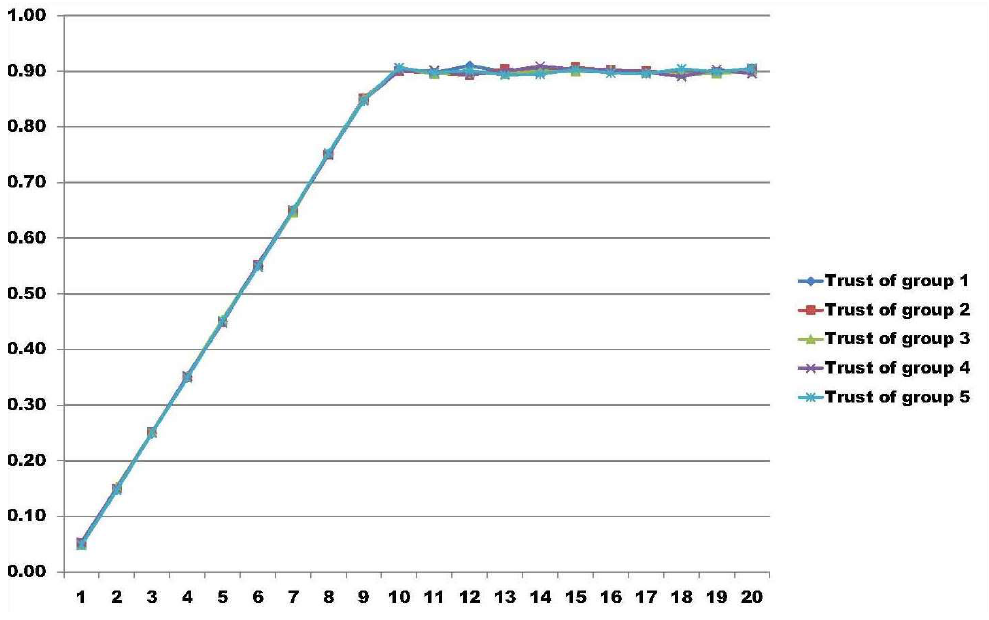
Figure 2. Ideal scenario where all groups are trustworthy.